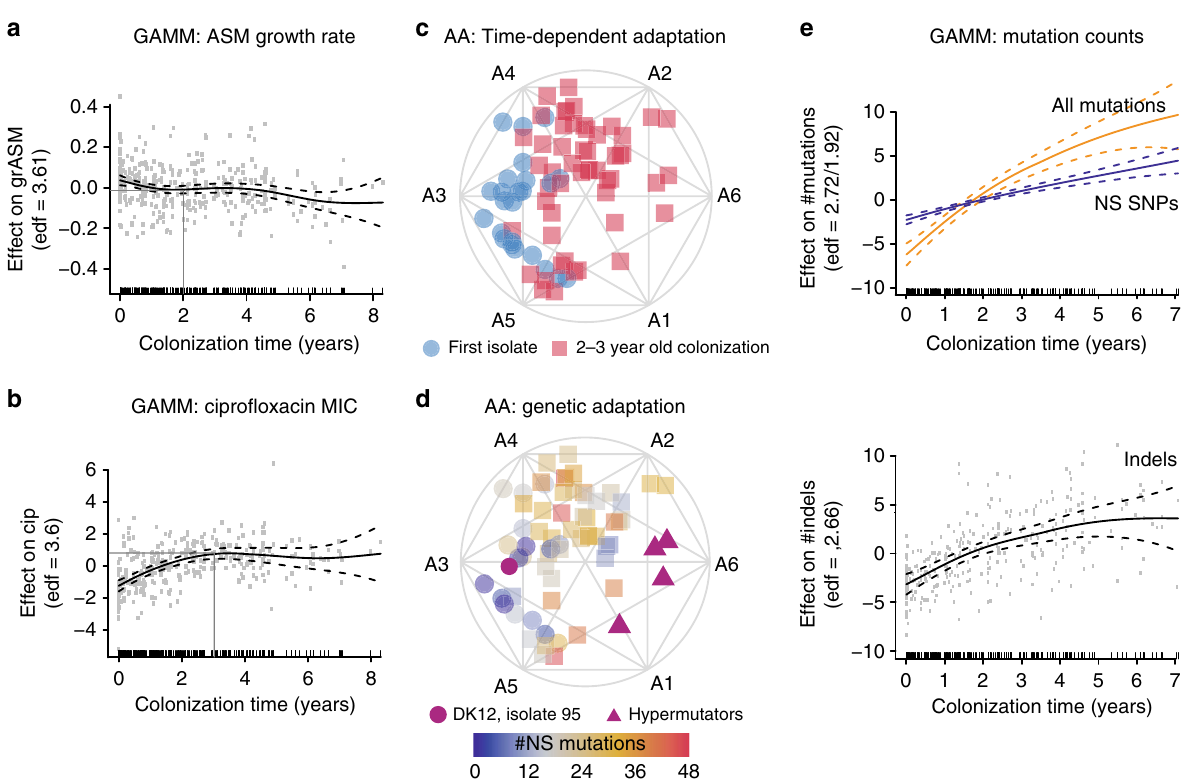
Fig. 4 Rapid early adaptation. GAMMs illustrate the signi fi cant impact of the explanatory variable colonization time on a growth rate in ASM, b cipro fl oxacin sensitivity in ASM, and e the accumulation of all mutations (orange), nonsynonymous SNPs (blue) and indels (insertions and deletions). We also illustrate the proposed initial adaptation period by dark grey reference lines in a and b . ( a/b/e notation) GAMMs are illustrated by solid smoothed trendlines, dashed two standard error bounds, and gray points as residuals. Y -axes are labelled by the predictor variable on which the effect of colonization time of the clone type has been estimated as well as the estimated degrees of freedom (edf) (for the e upper panel the edf is ordered as all mutations/NS SNPs). Residuals have not been plotted in the upper panel of e for clarity reasons. X -axes are the colonization time in years and patients are included as random smooths together with time. A rug plot is also visible on the x -axis to indicate the density of observations over time. Simplex visualizations of AA show ( c ) naive trait alignment of the fi rst isolate of the twenty patients where we have analyzed the fi rst P. aeruginosa isolate ever cultured at the CF clinic (blue circles) in contrast to evolved isolates that have been cultured at year 2 – 3 of colonization (red squares, all patients of the dataset). We contrast this trait-based ordination with ( d ) genetic adaptation, shown by a color overlay of the number of nonsynonymous mutations present in each isolate. Isolate 95 (purple circle) of the DK12 clone type has a very high number of mutations (>100) because one isolate in that lineage (isolate 96) is very different from the remaining 11 isolates. For the GAMM analysis shown in Fig. 4e, we fi ltered out the mutations from the errant DK12 96 single isolate that affected the whole lineage. Hypermutators are marked by purple